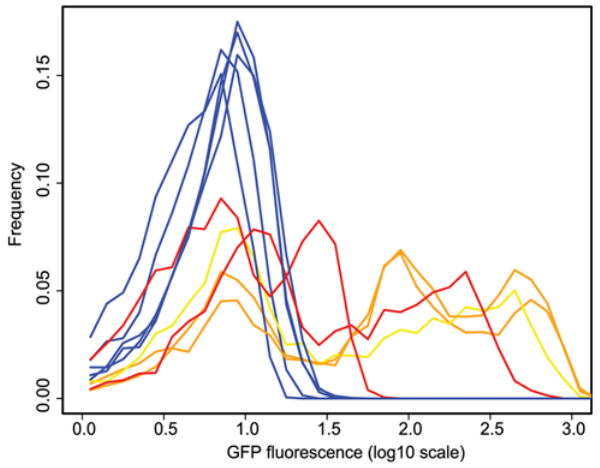
Figure 2. Histograms of GFP expression from clones exhibiting the highest level of noise in each population. Clones from each of the ten populations were ranked according to the amount of noise in GFP expression produced. A histogram of GFP expression was plotted for a single clone from each population with the highest level of noise. Clones from selected populations (red, orange, and yellow lines) show a much higher level of noise than the control those from control populations (blue lines). Clones containing the fliC promoter are orange and a clone containing the flgK promoter is yellow.